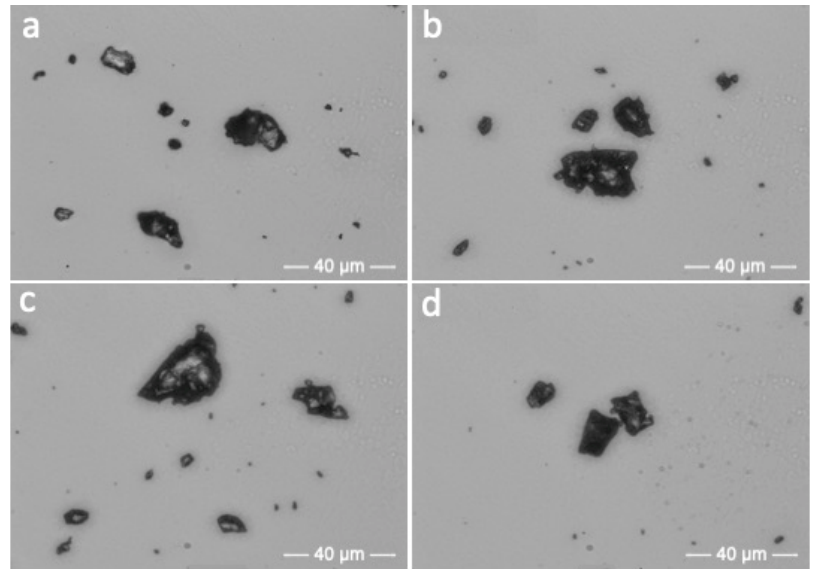
Figure 1. Optical microscopy photos of HAp samples: Dop0 ( a ); Dop1 ( b ); Dop2 ( c ); Dop3 ( d ).